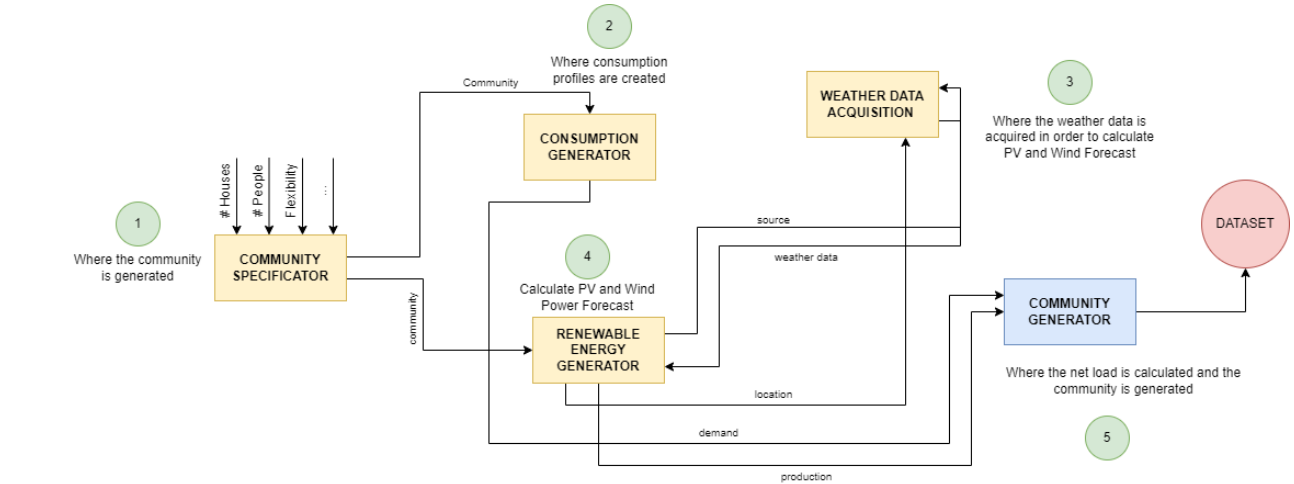
Figure 1. PROCSIM modules’ representation